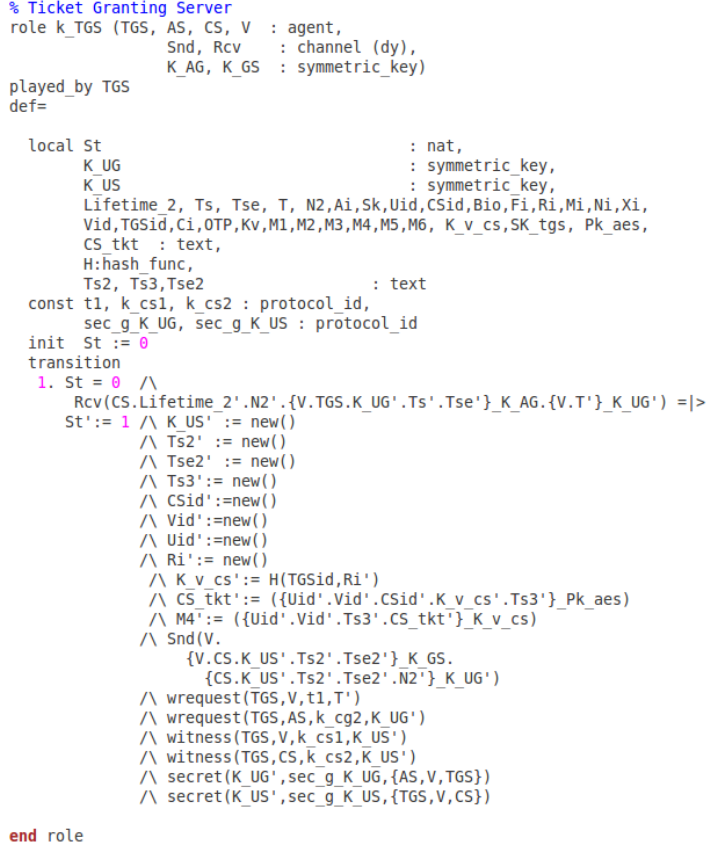
Figure 13. The TGS’s role in